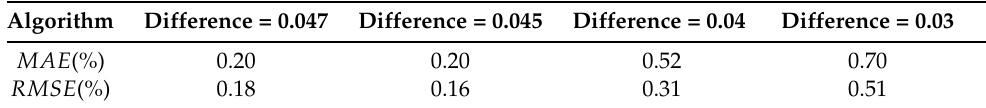
Figure 12. Forgetting factors differential comparison and its error curve: ( a ) SOC, ( b ) Error. Table 4. RMSE and MAE under different forgetting